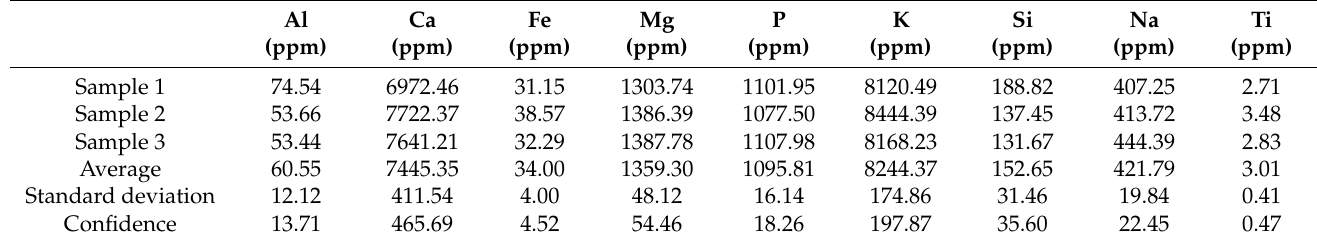
Table 7. Major elements results for dry